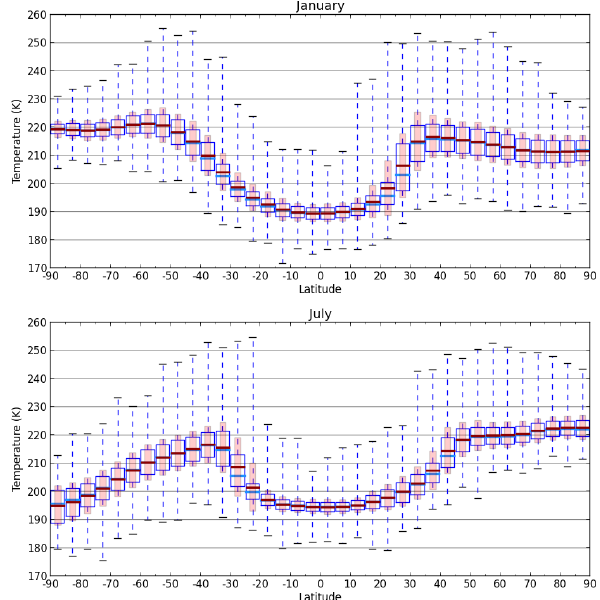
Figure 5. Altitudes of the first (lowest; red) and second (orange) tropopause versus latitude for January (top) and July (bottom) 2008. Mean (dark red) and median (blue) of first (solid) and second (dashed) tropopause of 5 ◦ latitudinal bands are indicated by hori- zontal